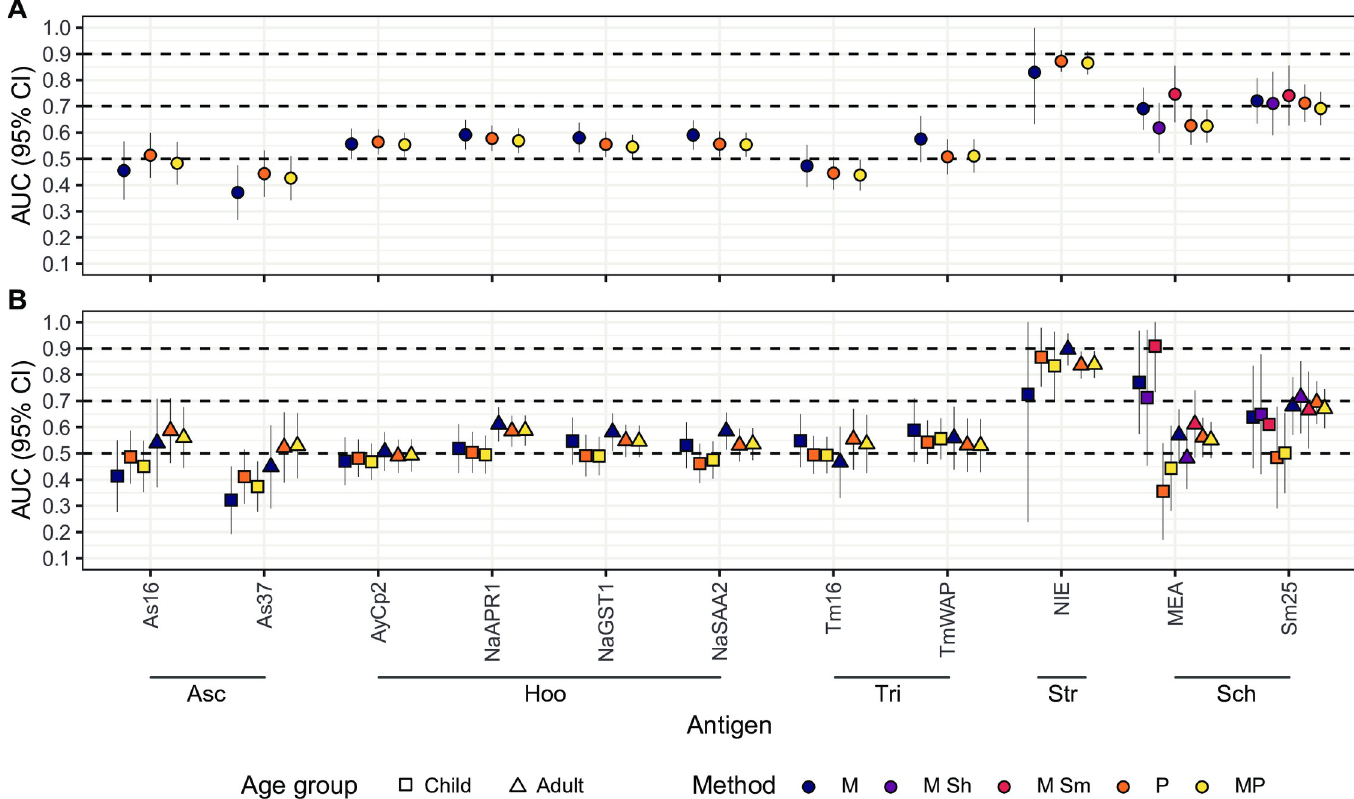
Fig 2. Areas under the curve from receiver operating characteristic curve analysis for helminth-specific IgG levels in the whole population (A) or stratified by age (B). Dashed lines represent the accuracy thresholds: null if AUC < 0.5, low if 0.5 � AUC > 0.7, moderate if 0.7 � AUC > 0.9 and high if AUC � 0.9. AUC: Area Under the Curve; CI: Confidence Interval; M: Microscopy; P: qPCR; MP: Microscopy and qPCR combined. Asc: Ascaris spp.; Hoo: Hookworm; Tri: Trichuris spp.; Str: Strongyloides stercoralis ; Sch: Schistosoma spp.; Sh: Schistosoma haematobium ; Sm: Schistosoma mansoni . Complementary information for this figure can be found in S2 Table .